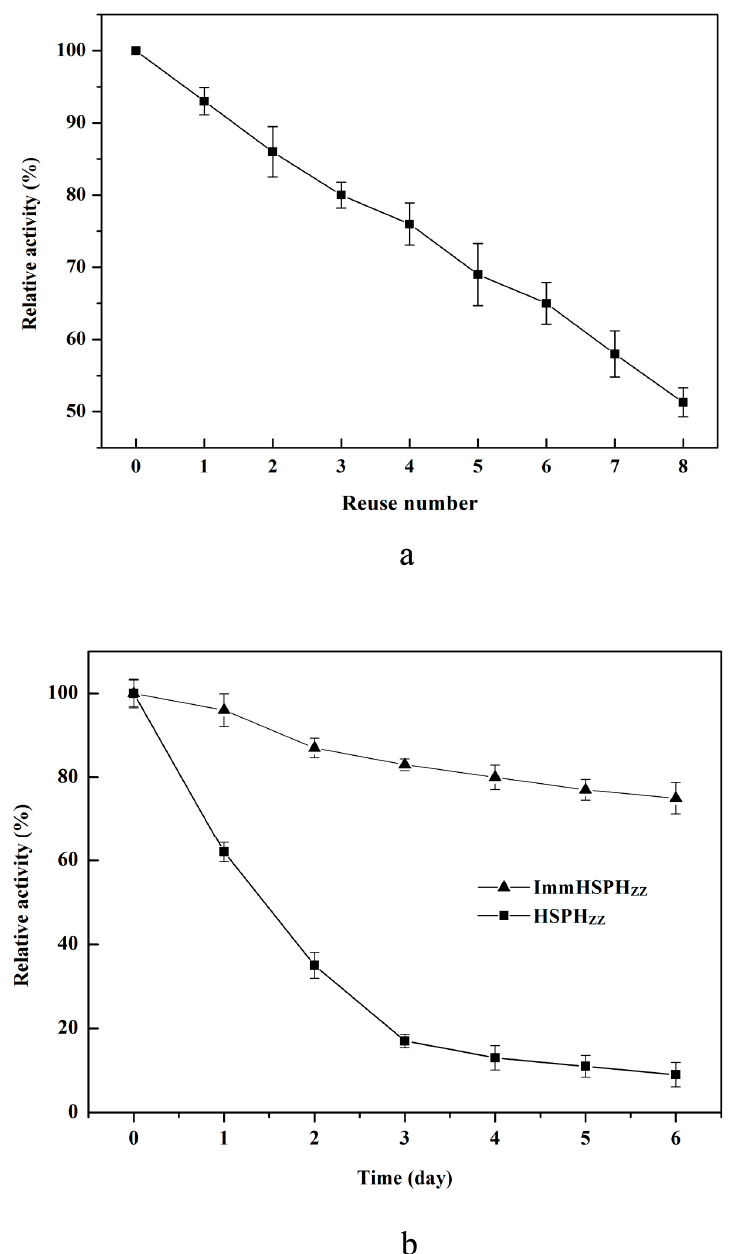
Figure 8. Stability of reusability ( a ) and storage ( b ) of immobilized ImmHSPH ZZ .